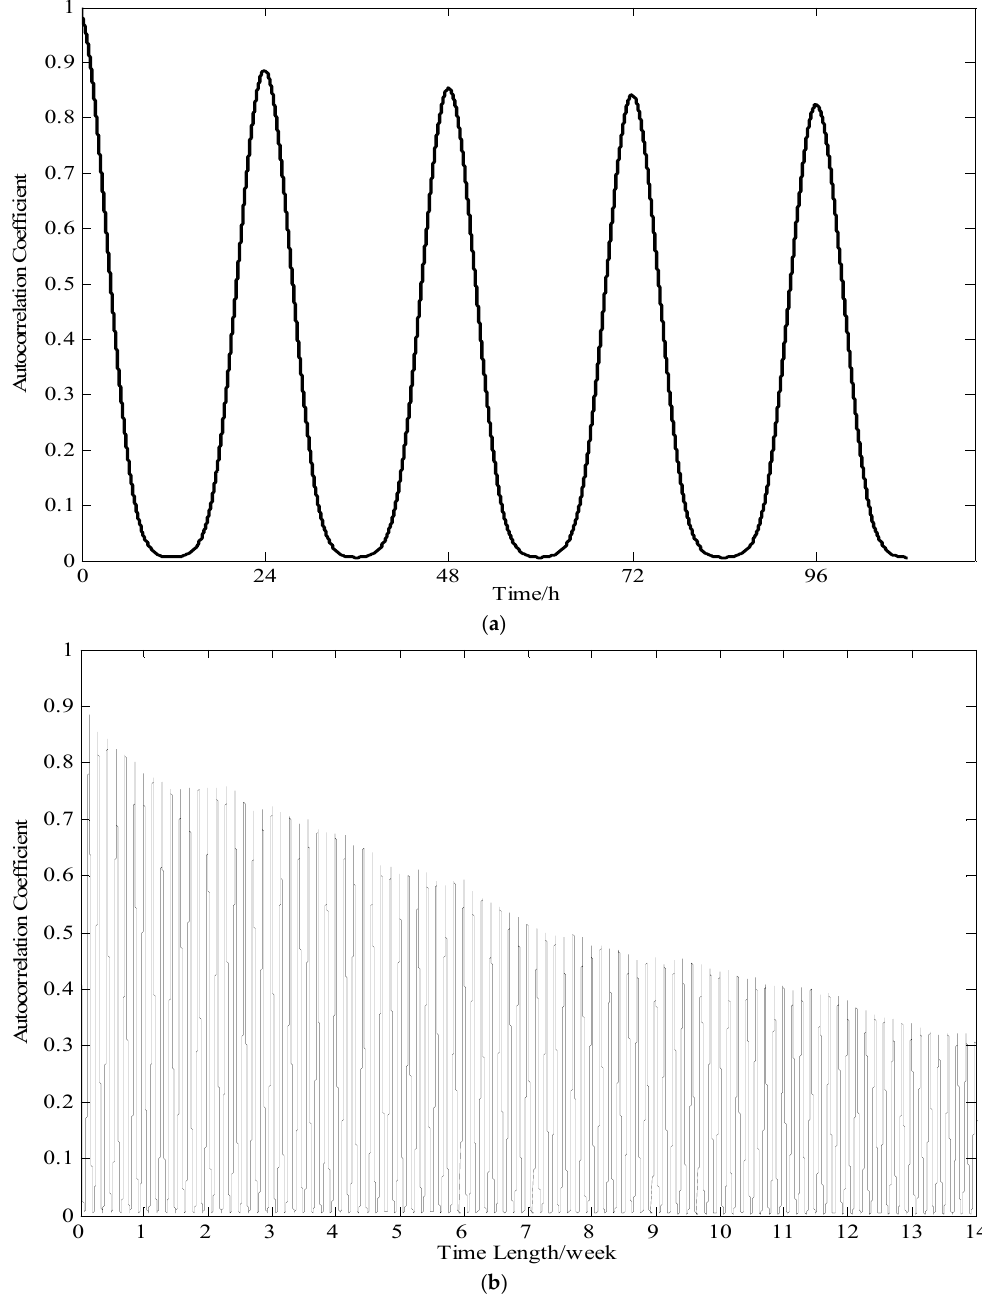
Figure 2. Autocorrelation coefficient of PV output data. ( a ) 96-h autocorrelation coefficient and ( b ) 2400-h autocorrelation coefficient.